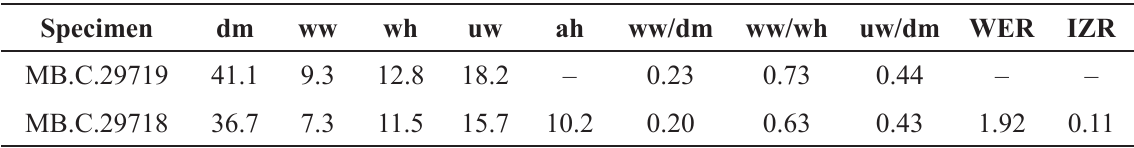
Table 4. Conch dimensions (partly estimated) and ratios of selected specimens of Shevyrevites corrugatus Korn & Hairapetian sp. nov. from Baghuk Mountain.